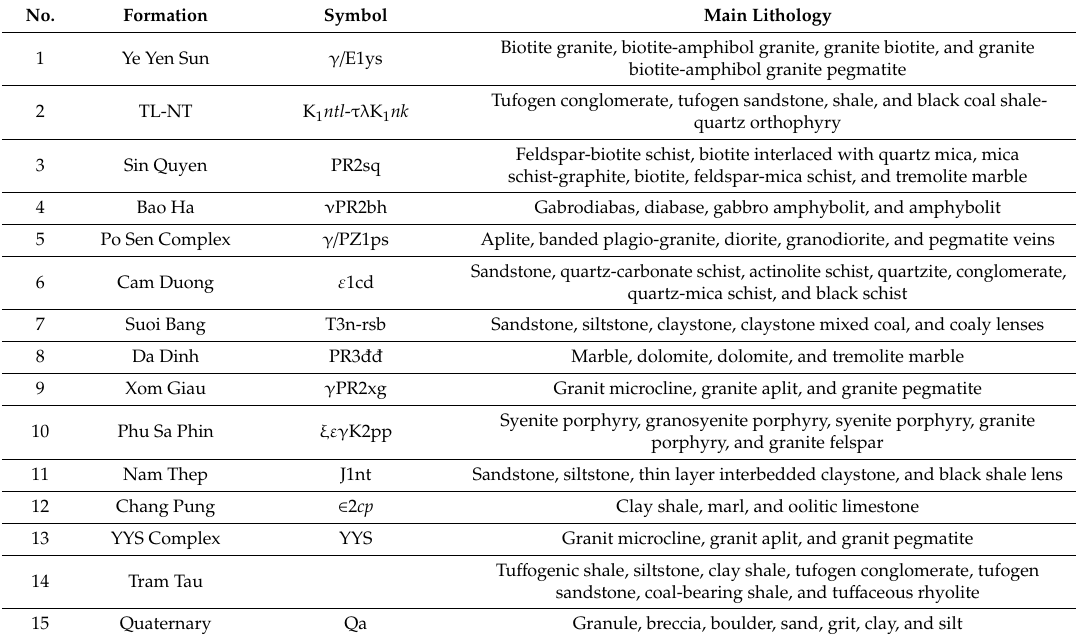
Table 1. Geological characteristics in the study